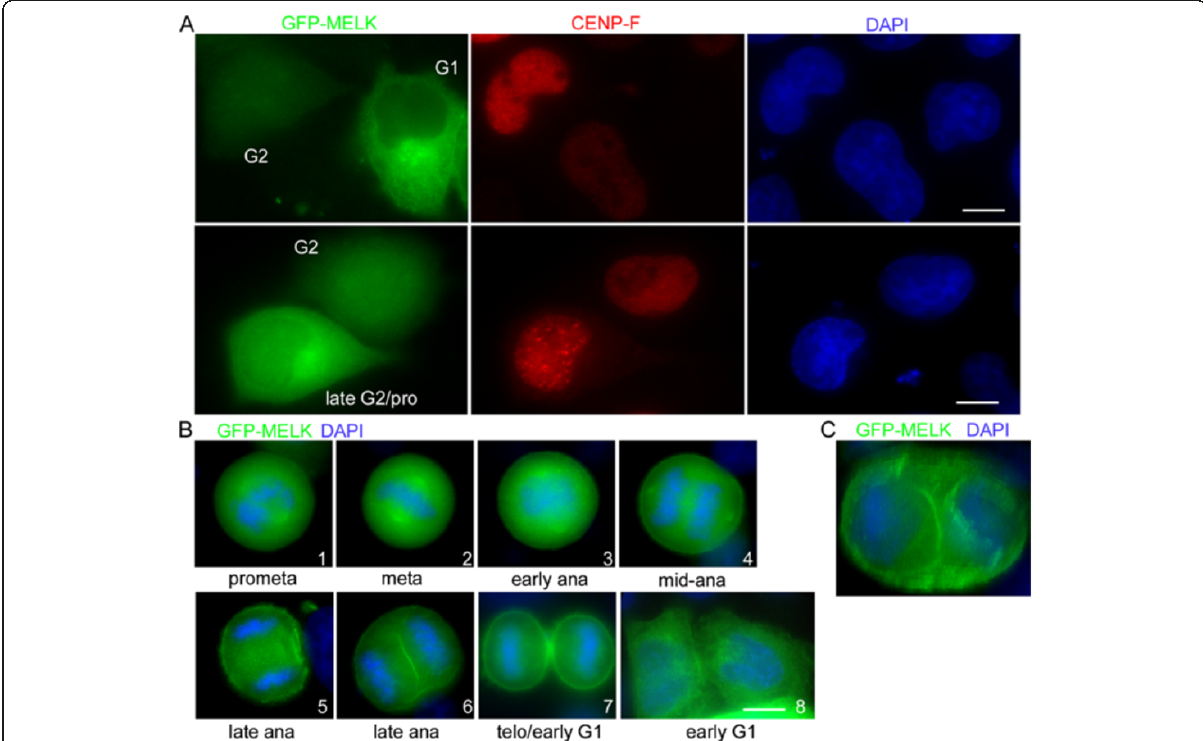
Figure 5 Dynamic subcellular localization of GFP-MELK. ( A ). Distribution of GFP-MELK signals in the cytoplasm and nuclei in G1 and G2 cells. G1 and G2 cells are differentiated based on characteristic staining patterns of CENP-F (red) [82]. Note nuclear signals of GFP-MELK in G2 cells are neither due to overexpression of GFP fusions (compare the G1 and G2 cells in the top row), nor affected by strong CENP-F staining in the Alexa Fluor 555 channel (compare nuclear GFP signals in G2 and late G2 cells in the bottom row). DNA was counterstained with DAPI. Bar=10 μ m. ( B ) Dynamic cortical localization of GFP-MELK throughout mitosis. Note the GFP signals at the midzone of a late anaphase cell (6). Bar=10 μ m. ( C ) A 3-D presentation of two GFP-MELK bands at the presumptive cleavage furrow surrounding two groups of separated